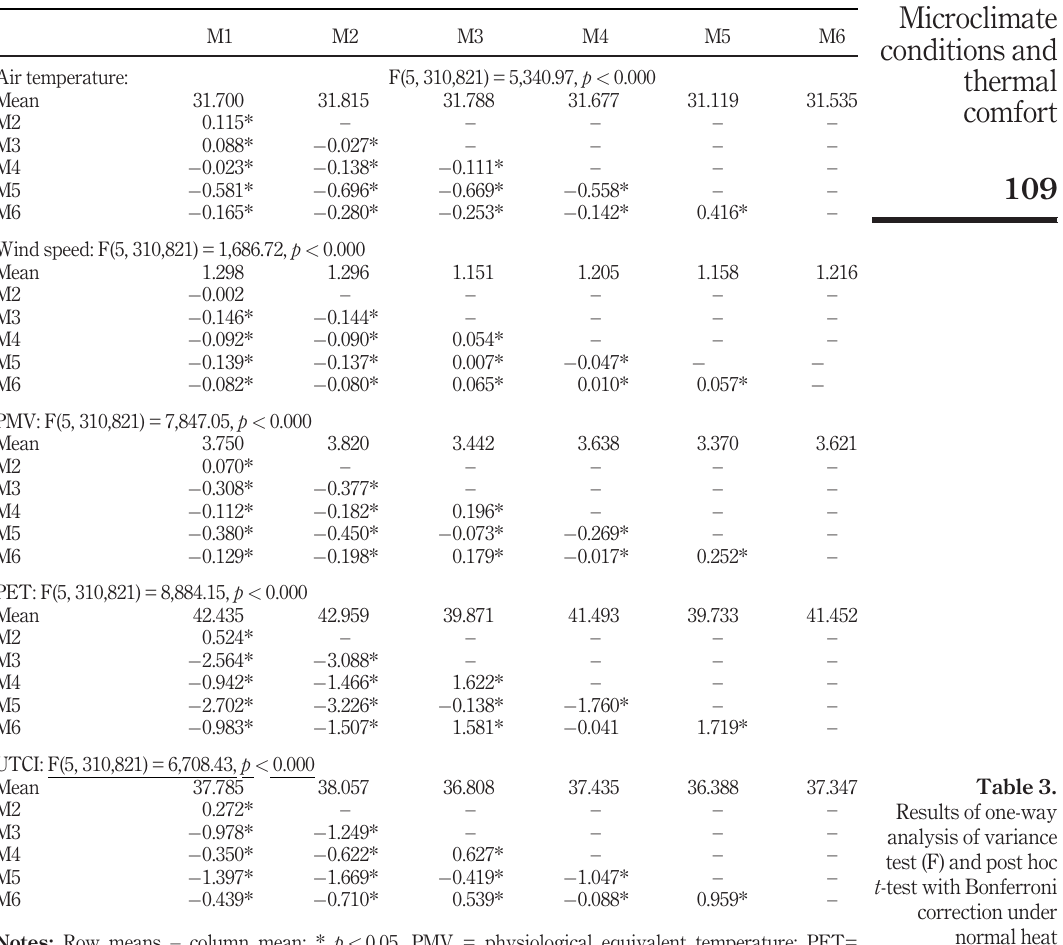
Table 3. Results of one-way analysis of variance test (F) and post